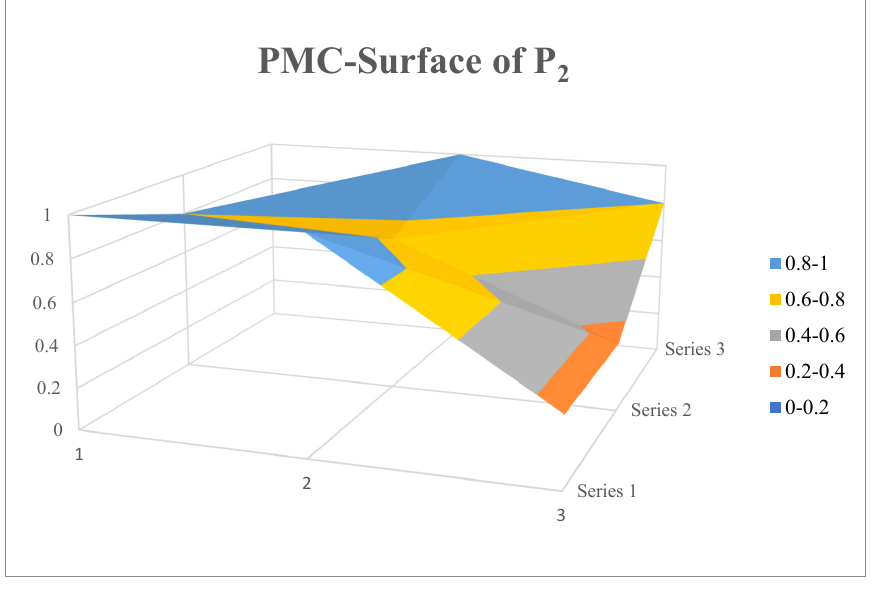
Figure 8. PMC-Surface of P 2.